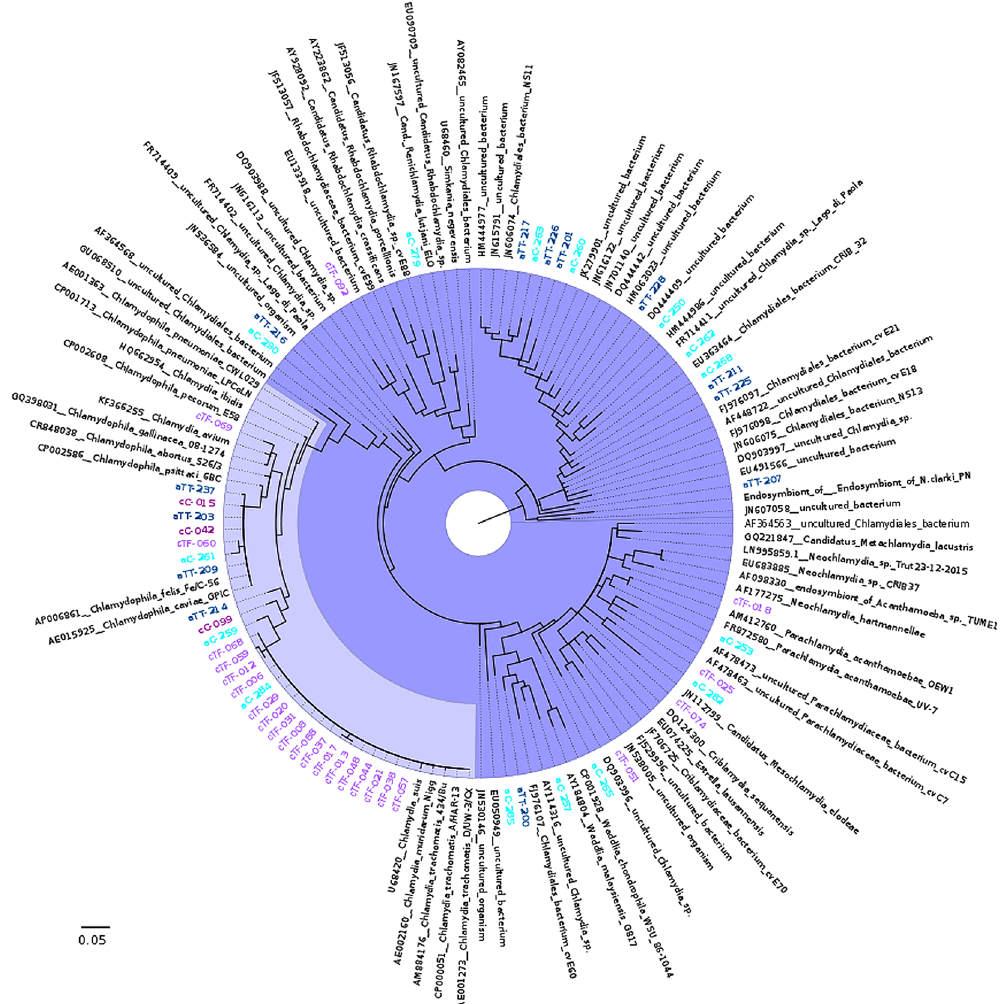
Figure 2. Phylogenetic affiliation of 16S rRNA gene sequences detected in this study. A Bayesian tree built from full-length chlamydial sequences is shown, to which the partial sequences generated in this study were added using Parsimony. Only sequences closely related to the sequences found in this study are depicted. The full dendrogram including all used sequences is available as Supplementary Fig. S2. Branches belonging to the Chlamydiaceae and CLOs are marked (light and dark purple, respectively). Sequences of cases (purple) and controls (dark purple) of children (cTF and cC, respectively), and cases (dark blue) and controls (cyan) of adults (aTT and aC, respectively), are